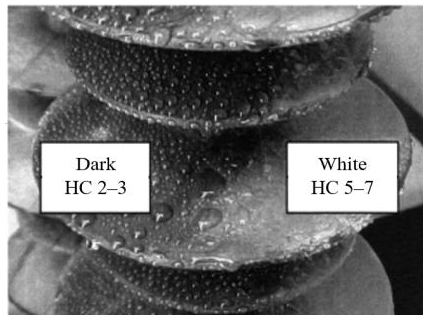
Figure 3. The hydrophobicity classification of the white and dark surfaces.